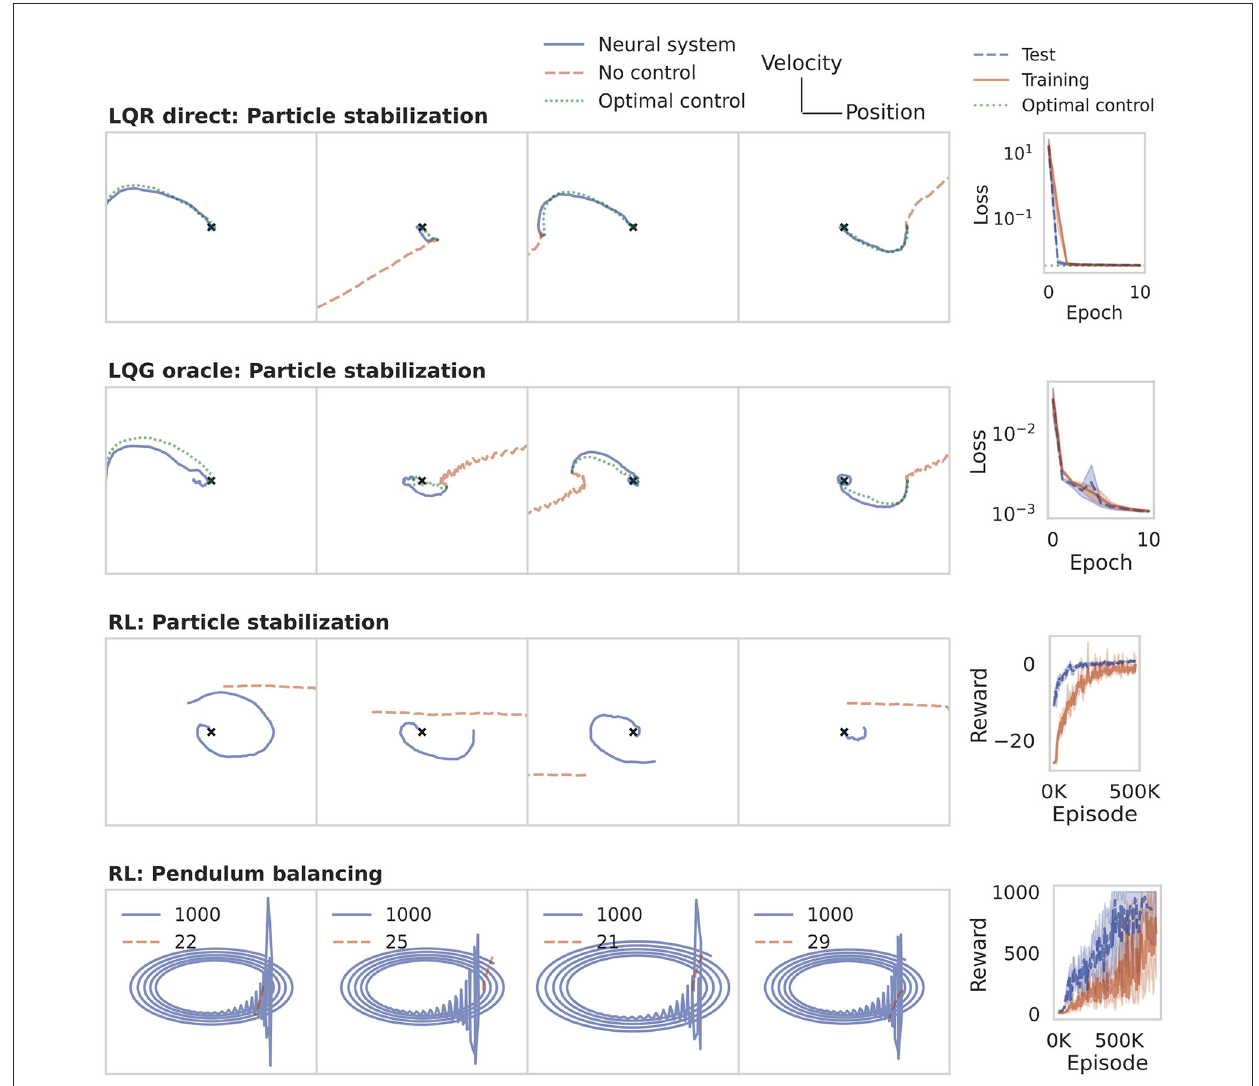
FIGURE4 Learning a control policy in the neural system. The panels on the left illustrate the evolution of the environment in state space. The panels on the right show the training curves of the RNN neural system. The rows illustrate the training methods discussed in Section 2.5, applied to the particle stabilization and pendulum balancing problem. The last row also shows the final rewards. In all four cases, the RNN system succeeds in learning a control policy to solve the